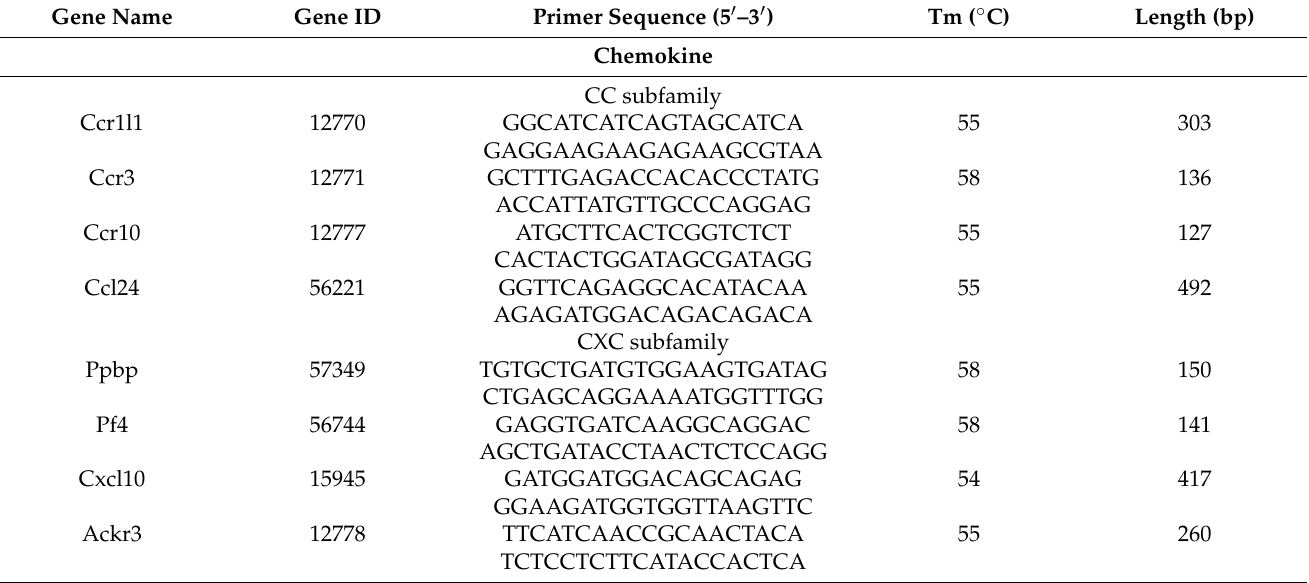
Table 1. Primer sequences for the qPCR validation of RNA-Seq